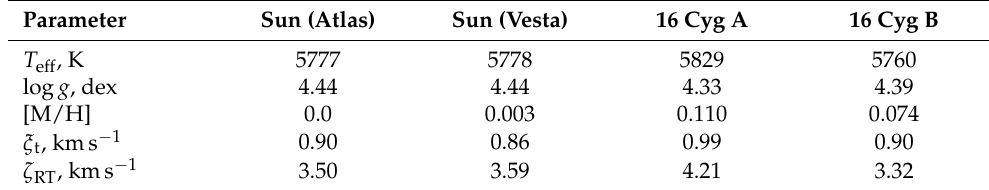
Table 1. Stellar parameters derived for the sun (Vesta) and in the binary system 16 Cyg using atomic and molecular lines.